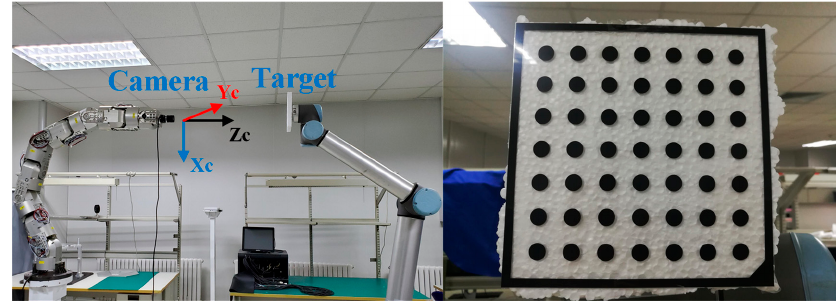
Figure 13. Experiment platform and target.